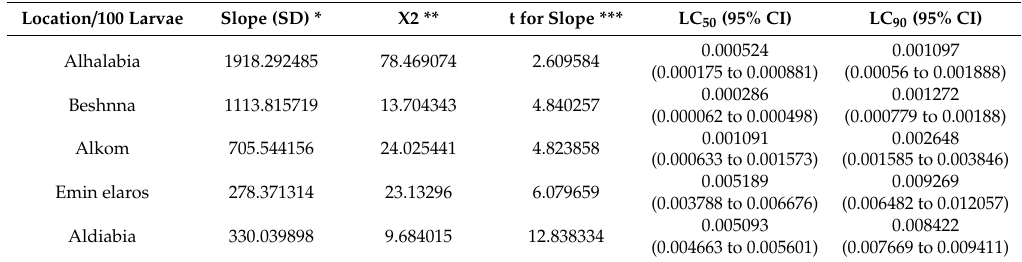
Table 1. Lethal concentration 50 (LC 50 ) and LC 90 of 14-day-old larvae treated with ivermectin using a larval immersion test.